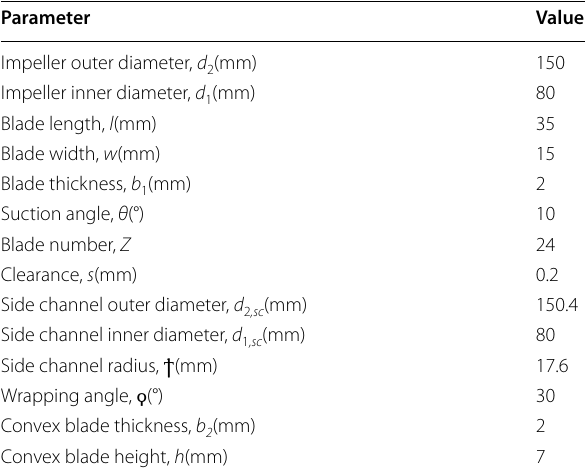
Table 1 Specifications of the side channel pump